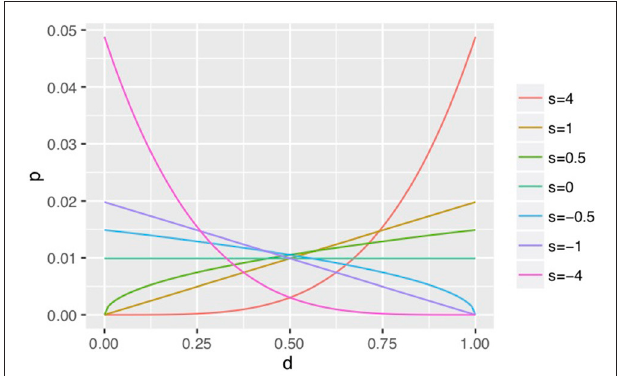
relationships (Pachur et al., 2012; Takano and Fukuda,